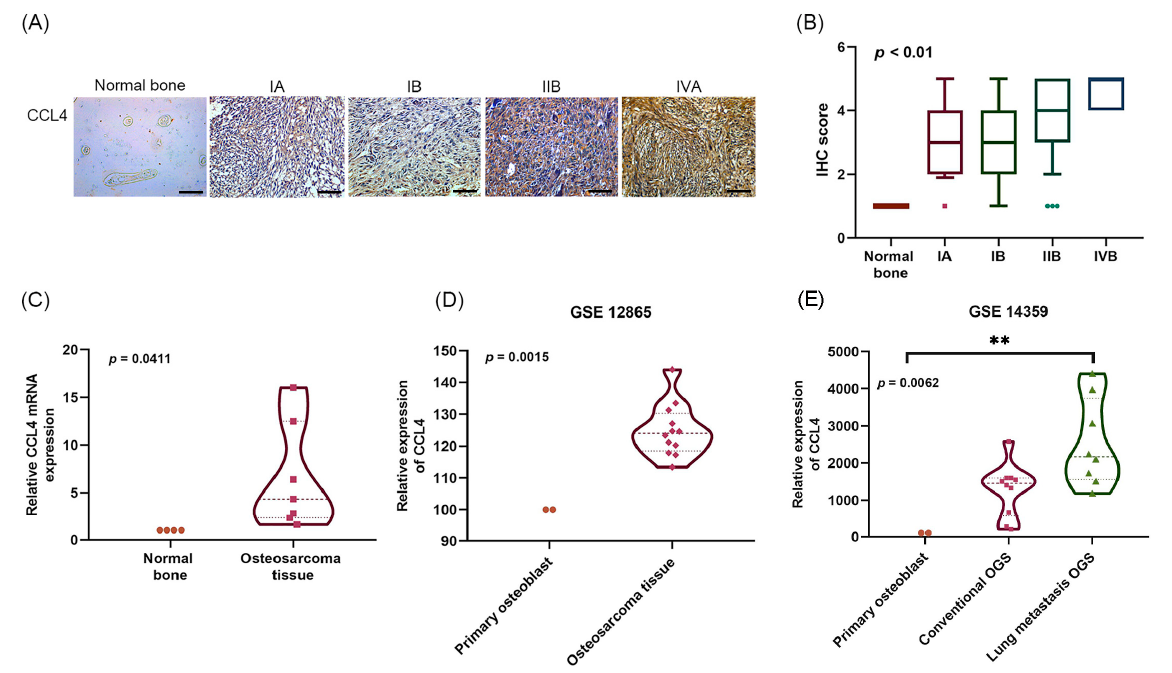
Figure 1. Clinicopathological characteristics of CCL4 in human osteosarcoma tissue. ( A , B ) Normal bone and osteosarcoma specimens were subjected to immunohistochemistry (IHC) evaluations with anti-CCL4 monoclonal antibody (scale bar = 100 µ m). Staining intensity was graded as 0 (no staining), 1 (<25% of the cells with positive staining), 2 (25–49% of the cells with positive staining), 3 (50–74% of the cells with positive staining), or 4 (50–100% of the cells with positive staining). ( C ) CCL4 mRNA expression in normal bone and osteosarcoma tissue in the study hospital samples was detected by qPCR. ( D ) CCL4 mRNA expression in primary osteoblast and osteosarcoma tissue was analyzed using records from the Gene Expression Omnibus (GEO) Dataset GSE12865. ( E ) CCL4 mRNA expression in primary osteoblasts, conventional osteosarcoma (OGS), and lung metastatic OGS was analyzed using records from the GEO Dataset GSE14359. ** p < 0.01 compared with the control group.